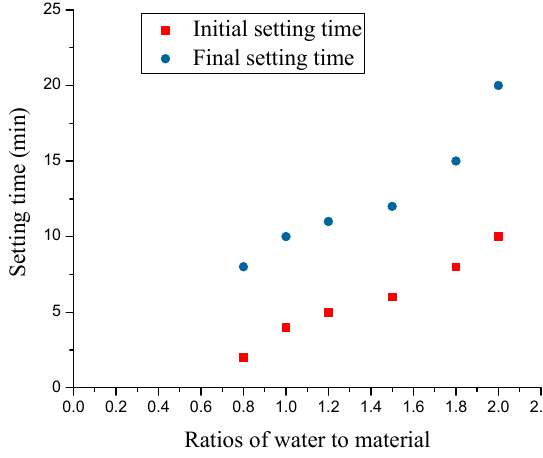
Figure 5. Setting time of grouting materials with different water-to-material ratios.